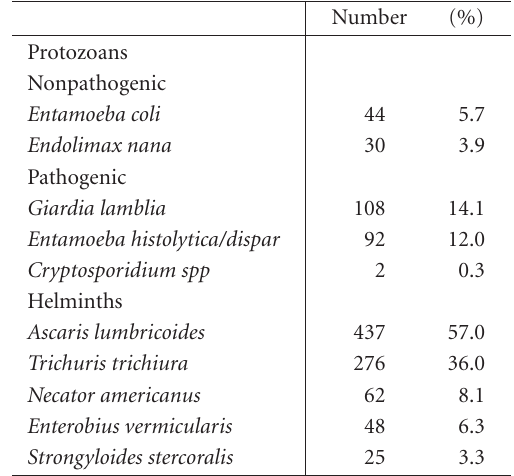
Table 1: Parasite positivity in stool specimens examined from preg- nant women